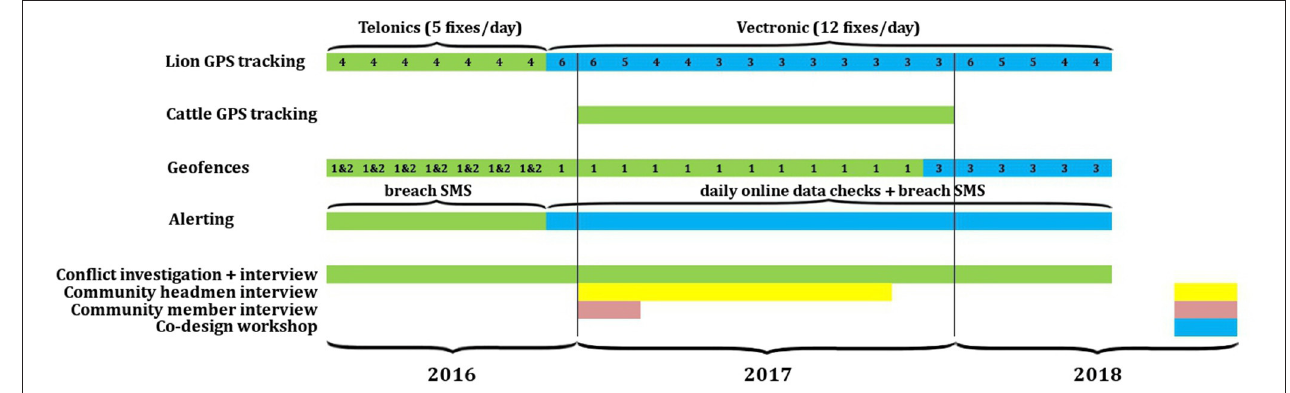
FIGURE 1 | Timeline of key research activities and lion alert system elements during the pilot study. Numbers in row “Lion GPS tracking” represent monthly sample sizes. Numbers in row “Geofences” indicate which virtual boundaries (see Figure 2 ) triggered alerts.